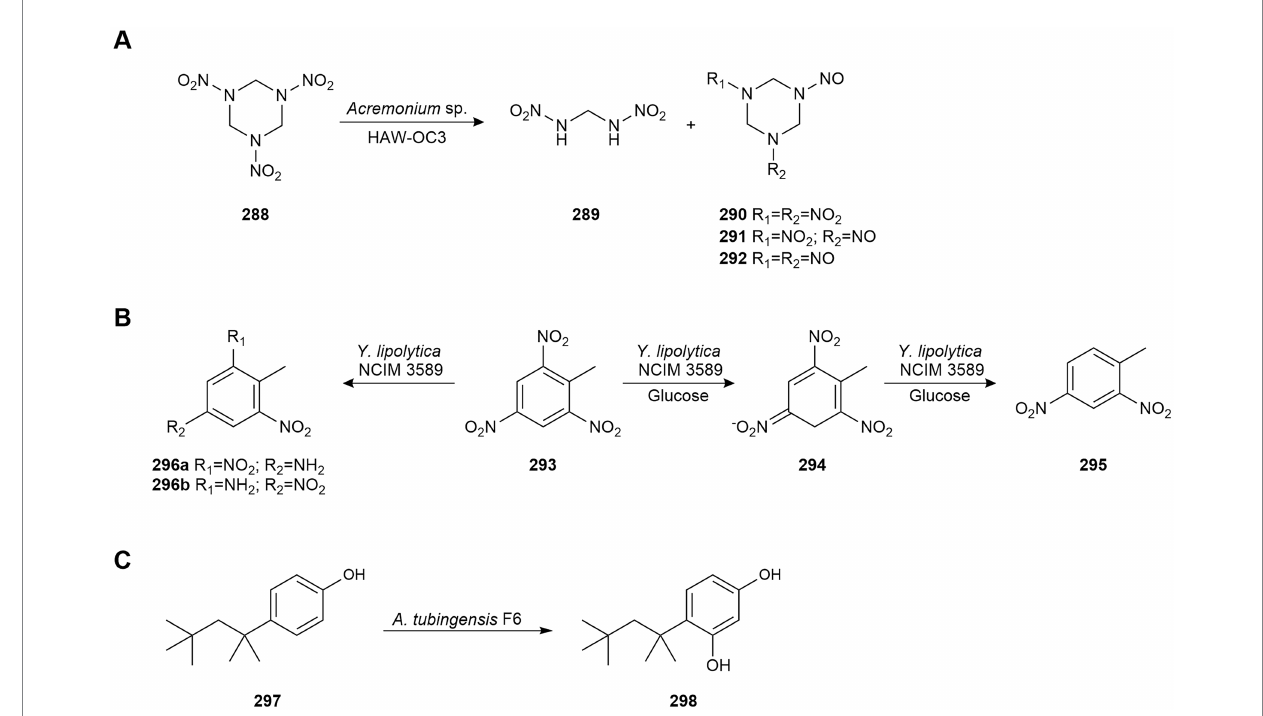
FIGURE 14 Biodegradations of other persistent organic pollutants. (A) Bioremediation of munitions compound hexahydro-1,3,5-trinitro-1,3,5-triazine ( 288 ) by Acremonium sp. HAW-OC3 (Bhatt et al., 2006). (B) Biodegradation of the explosive TNT ( 293 ) by Yarrowia lipolytica NCIM 3589 (Jain et al., 2004). (C) Biodegradation of the chemical 4- tert -octylphenol ( 297 ) by Aspergillus tubingensis F6 (Kuzikova et al.,